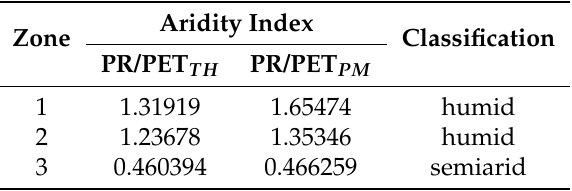
Table 1. Aridity index calculated for each zone of the area and from PET using the Thornthwaite and Penman–Monteith mathematical